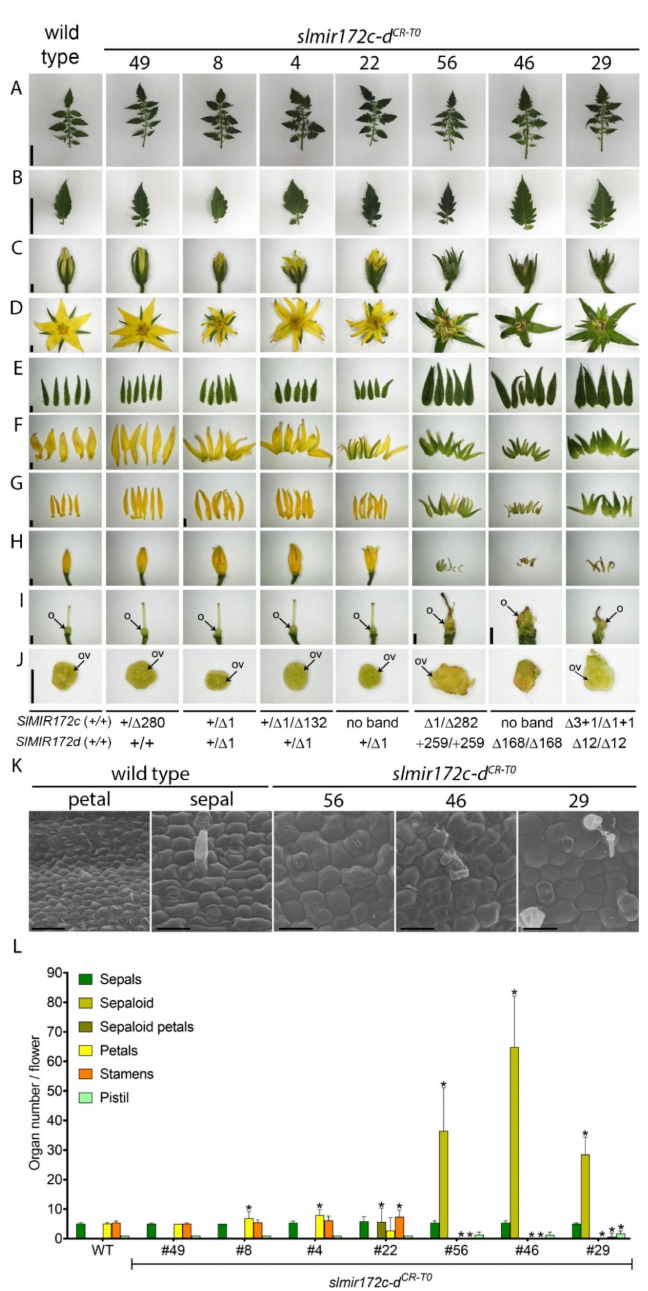
Figure 3. Leaf and flower phenotypes of slmir172c-d CR-T0 plants. ( A – J ) Representative pictures of wild type and indicated mutant plants fully expanded leaves ( A ), their terminal leaflets ( B ), stage 18 flower buds ( C ), anthesis flowers ( D ), their sepals ( E ), their petals or sepaloid organs ( F ), their stamens or sepaloid organs ( G ), their anther cone or sepaloid organs ( H ), their pistils ( I ) and manual cross sections of respective ovaries ( J ). O: ovary; OV: ovule. Scale bars = 5 cm for A , B ; 2 mm for C – J . ( K ) Scanning electron micrographs of the adaxial side of wild-type petals and sepals and indicated slmir172c-d CR-T0 plant sepal-like organs. Scale bars = 50 µ m. ( L ) Quantitation of flower organs in wild type and indicated mutant plants. Error bars indicate ± standard deviation ( n =10). Asterisks indicate significant difference ( p ≤ 0.01) compared with wild type as determined by Student’s t